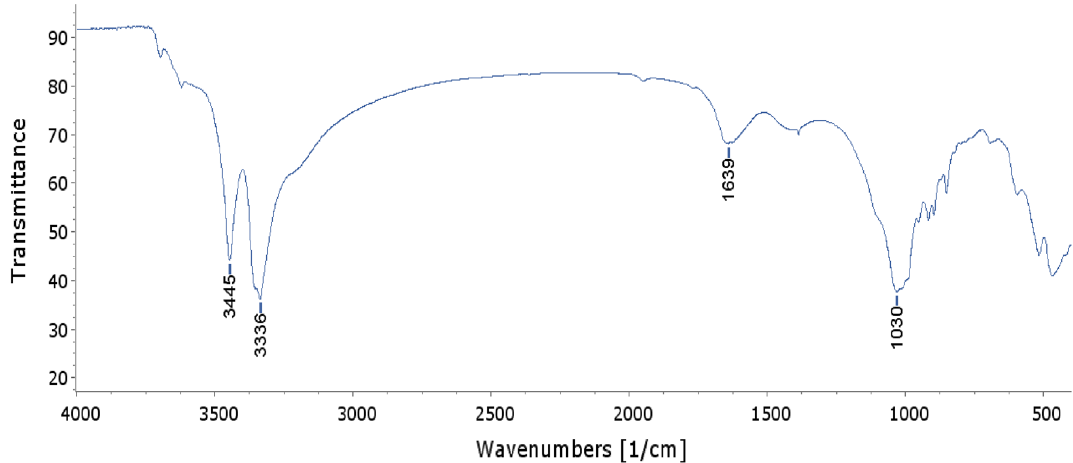
Figure 2. FTIR spectrum for the interior corrosion of the Cauldrom